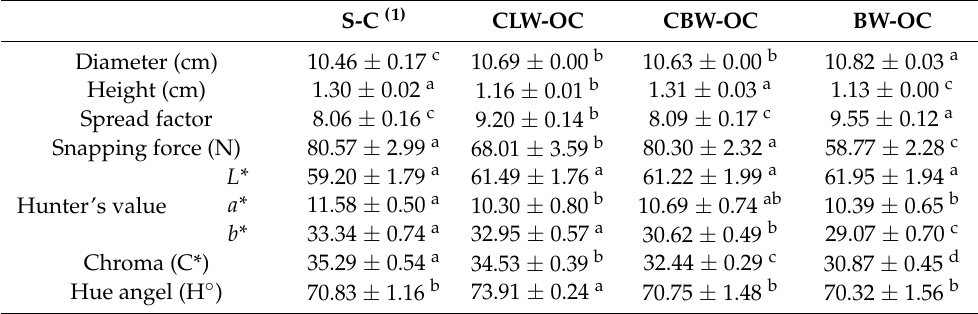
Table 3. Color, physical properties, and texture characteristics of cookies with